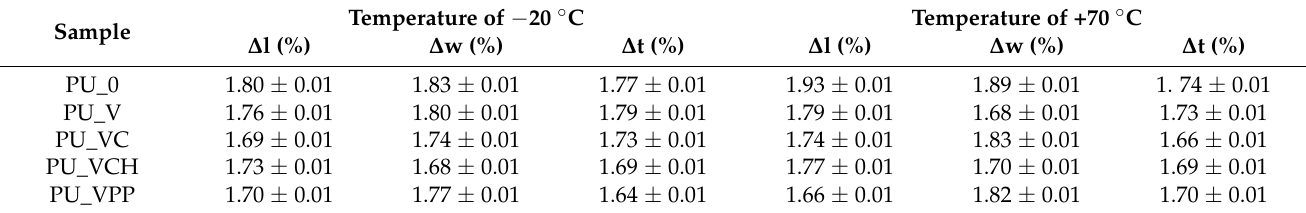
Table 2. Changes in linear dimensions, mass, and volume, after conditioning at − 20 ◦ C and +70 ◦ C, of polyurethane composites. Sample